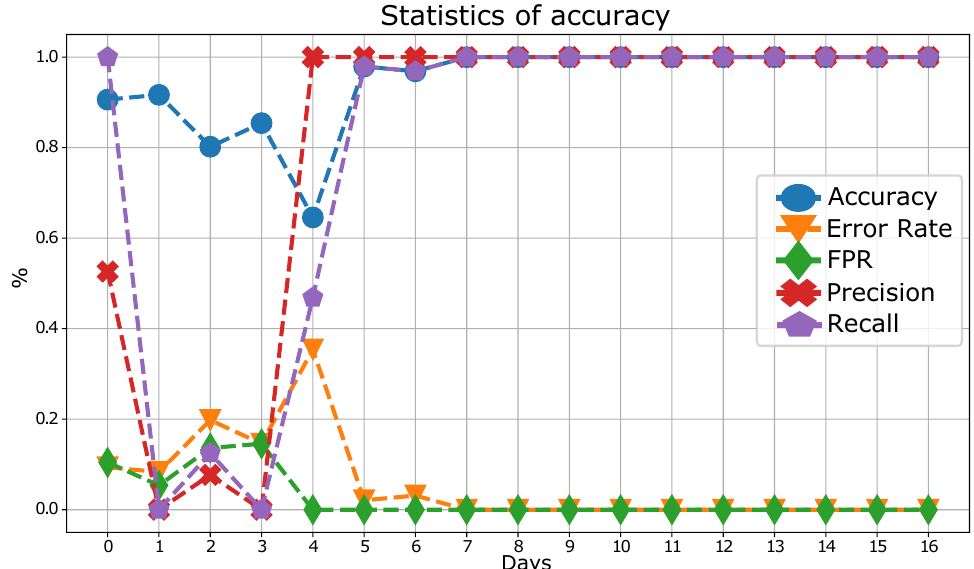
Figure 6. Statistics of algorithm using the proposed